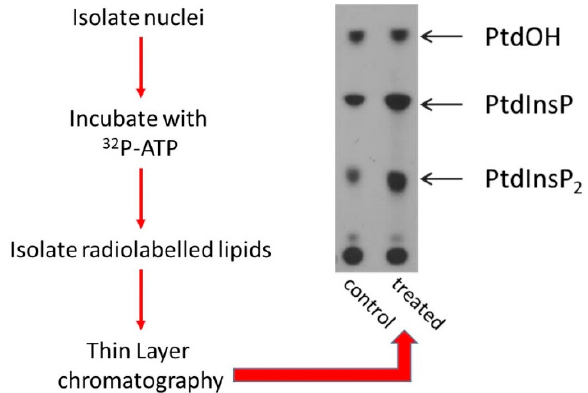
Figure 2. Nuclei from Murine erythroleukaemia cells (MEL) were isolated and incubated in the presence of 32 P γ -ATP for 5 minutes. The lipids were extracted and separated by thin layer chromatography. The control lane is nuclei from control murine erthroleukaemia (MEL) cells, while the treated lane shows nuclei isolated after di ff erentiation of MEL cells into erythroblasts. Labelled PtdOH suggests that a nuclear DAG kinase has access to a pool of DAG, labelled PtdIns4 P suggests that a nuclear PI-4-Kinase accesses a pool of PtdIns and labelled PtdIns(4,5) P 2 suggests that a nuclear PIPK can access a pool of PtdIns4 P . Note the increase in the labelling of nuclear PtdIns(4,5) P 2 . The right panel explains how label from 32 P γ -ATP is incorporated into the various lipids and defines substrates and enzymes.